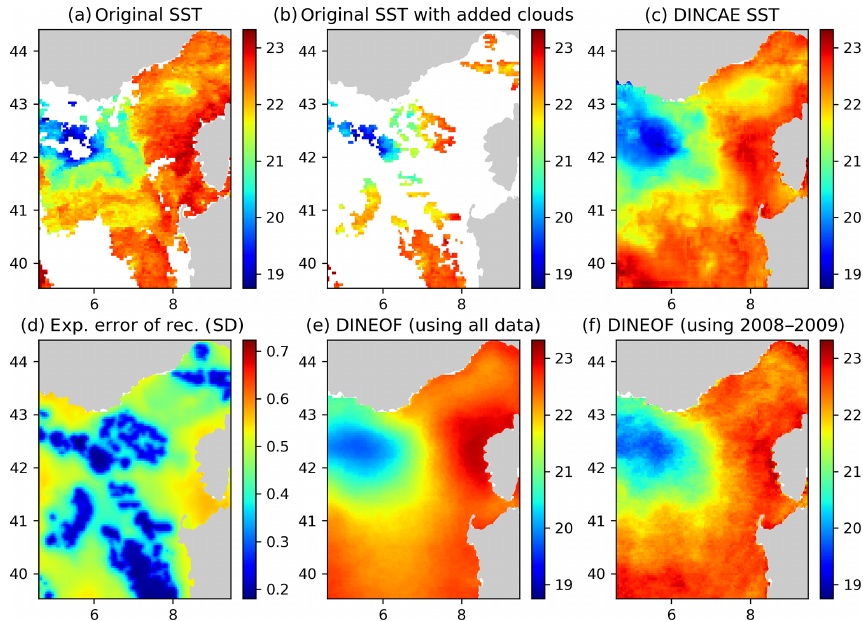
Figure 6. Panel (a) the original AVHRR SST, (b) AVHRR SST with additional clouds for cross-validation, (c) the DINCAE reconstruction, (d) the expected error standard deviation (SD) of the DINCAE reconstruction, (e) the DINEOF reconstruction using all data, (f) the DINEOF reconstruction using only the data from 2008 to 2009. All panels are in degrees Celsius and valid for the date 13 October 2009.